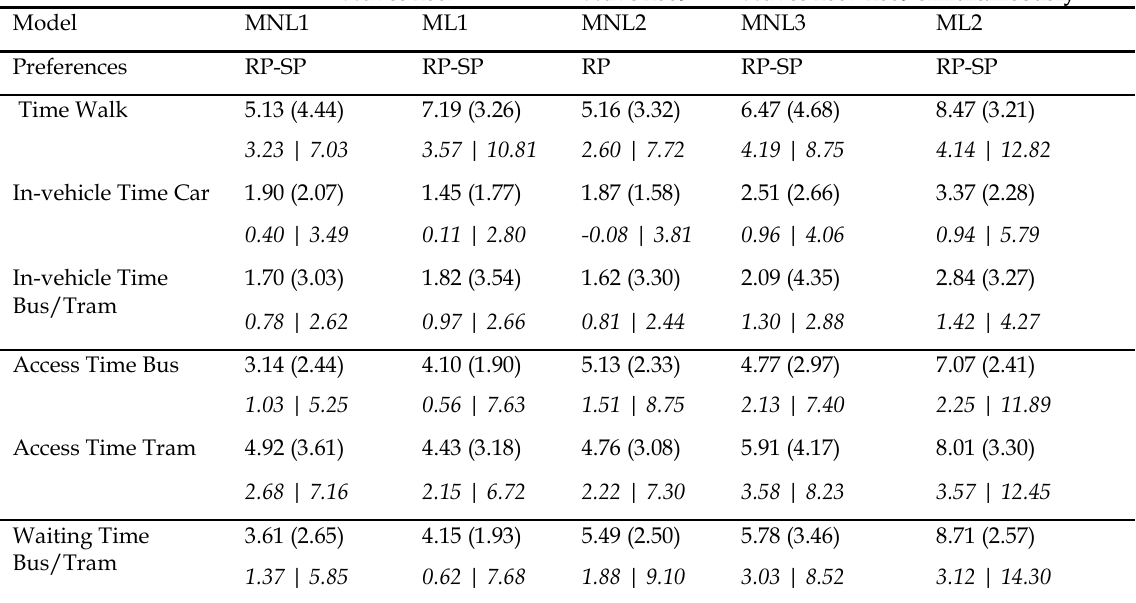
Table 6. Estimation